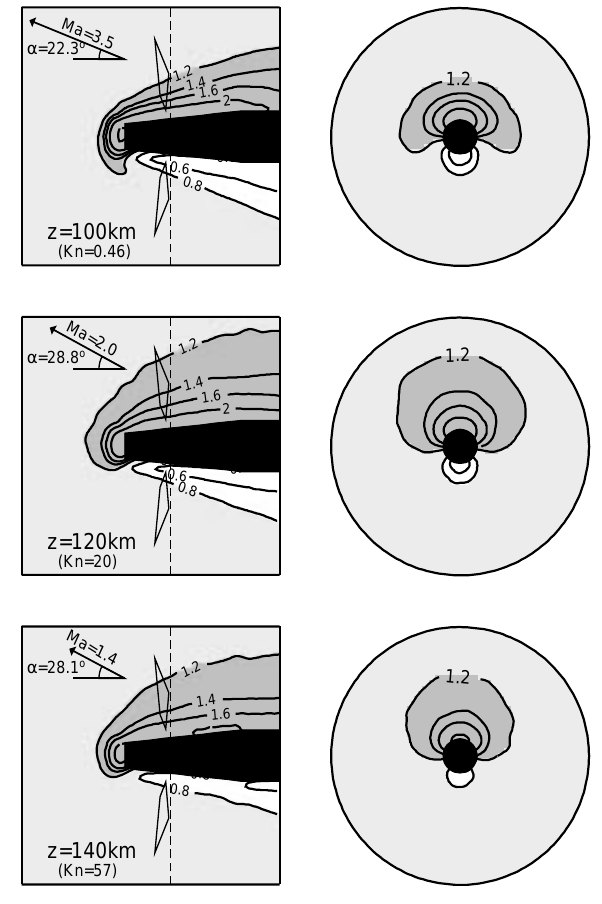
Fig. 6. Calculated relative density fields for 100, 120, and 140-km altitudes. Right panels show the cross-sectional views of the relative density fields at the dashed lines in the left